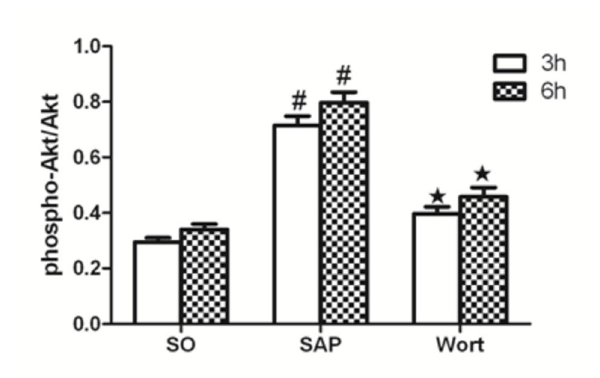
Figure 10. p-p38MAPK/p38MAPK protein expression in each group at the 3 h and 6 h time point. # P <0.05 vs. SO group; ★ P <0.05 vs. SAP group.